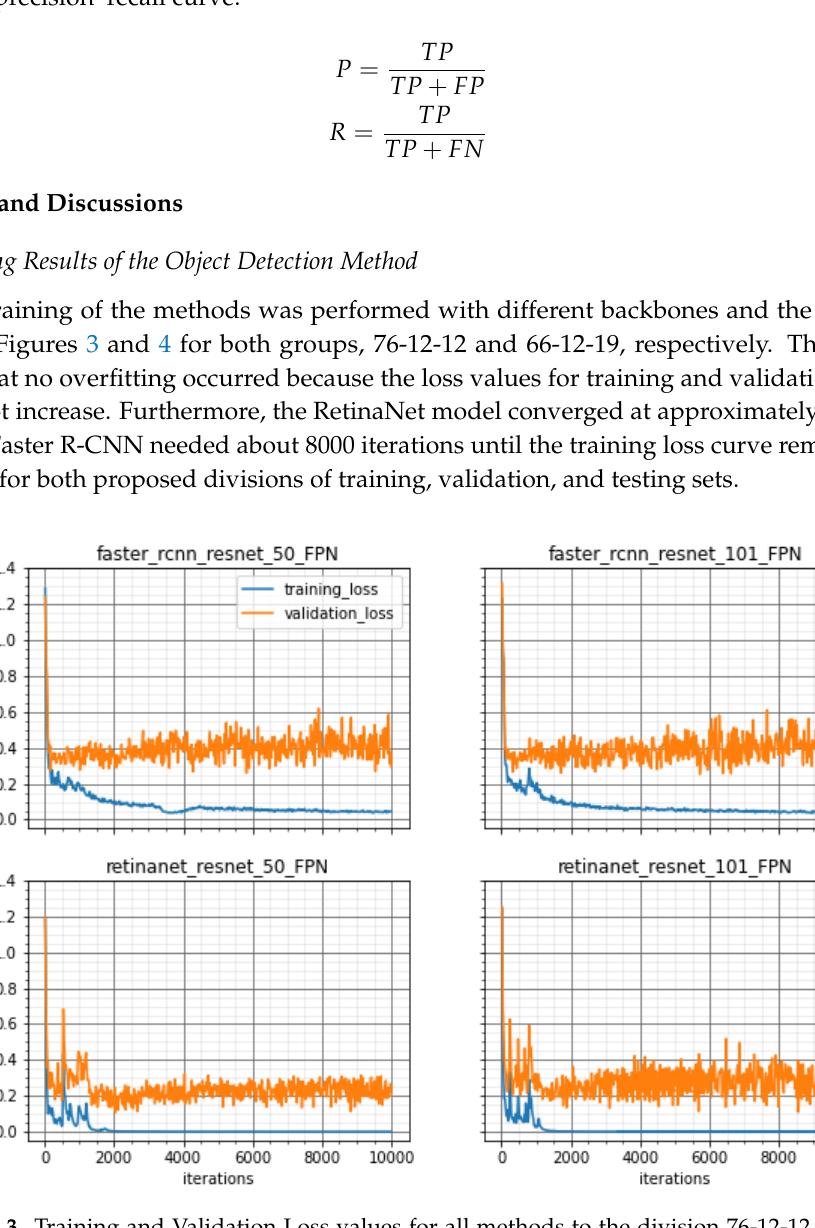
Figure 3. Training and Validation Loss values for all methods to the division 76-12-12 over 10,000 iterations of training